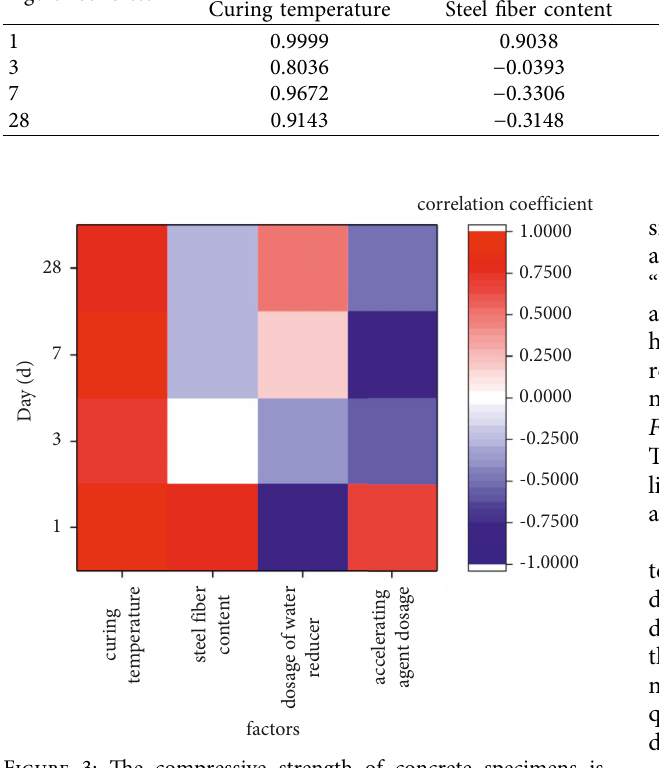
Table 7: The compressive strength of concrete specimens is correlated with various factors. Age of concrete